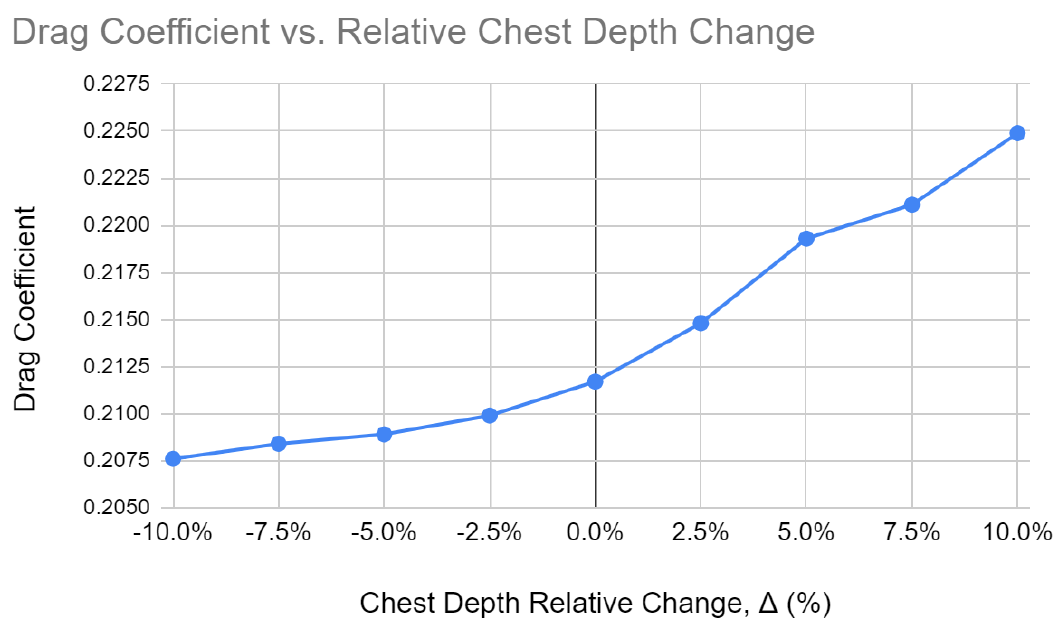
Figure 12. Graph of Relative Chest Depth Change (side view model) vs. Drag Coefficient.